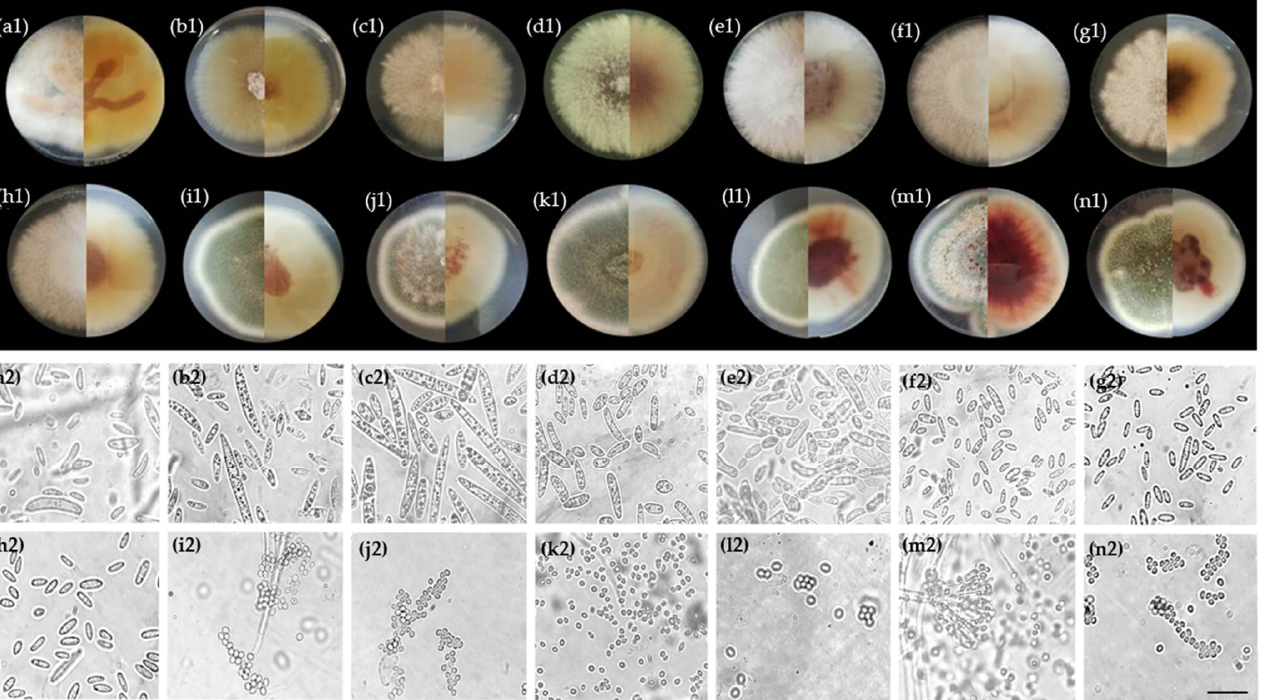
Figure 10. Morphological observations of fungal species isolated from pineapple-infected fruitlets and assayed in Koch’s postulates. (1) Colonies were incubated on potato dextrose agar (PDA) for 7 days at 27 °C in the dark. Each colony is shown from top (left) to bottom (right). (2) Conidia. Fusarium sacchari strains (a) BP138 and (b) BP575; Fusarium ananatum strain (c) BP383; Fusarium oxysporum strains (d) BP369 and (e) BP460; Fusarium proliferatum strains (f) BP114, (g) BP429, and (h) BP436; Talaromyces stollii strains (i) BP054, (j) BP185, and (k) BP462; Talaromyces amestolkiae strains (l) BP002, (m) BP257, and ( n ) BP605. Scale bar: 20 µm.